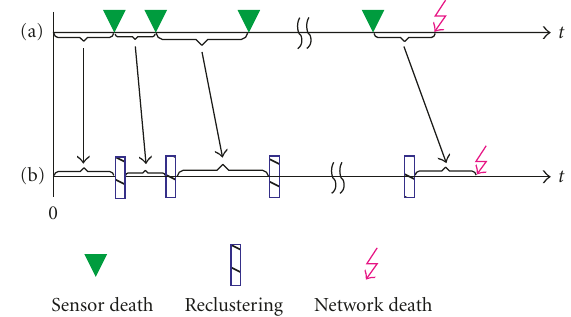
Figure 8: Pictorial description of the network time evolution. Two scenarios are considered: (a) absence of reclustering and (b) ideal